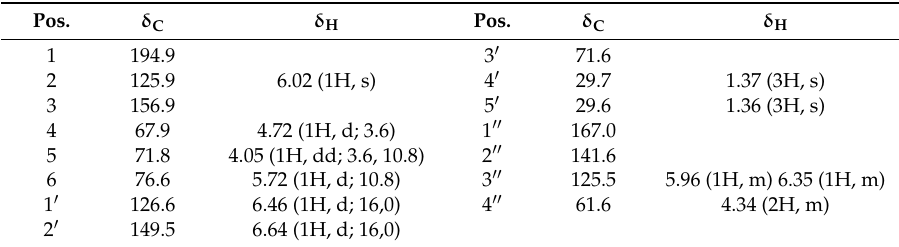
Table 2. NMR data for compound 3 in MeOH -d 4 , ( J in Hz; 1 H-NMR at 600 MHz; 13 C-NMR at 150 MHz).